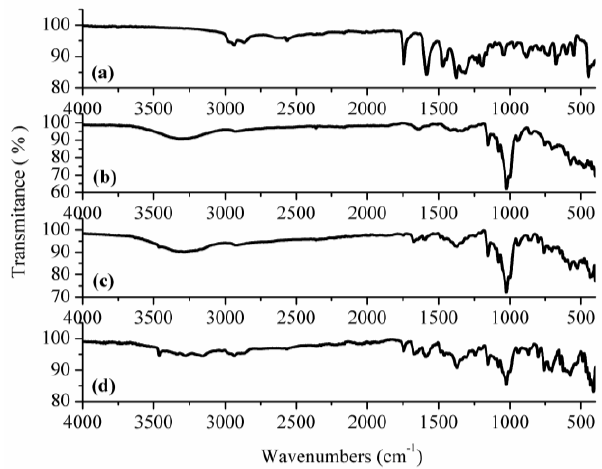
Figure 1. FTIR spectra of the ( a ) captopril (CAP), ( b ) β -cyclodextrin ( β -CD) and ( c ) CAP- β -CD physical mixture and ( d ) CAP- β -CD inclusion complex.